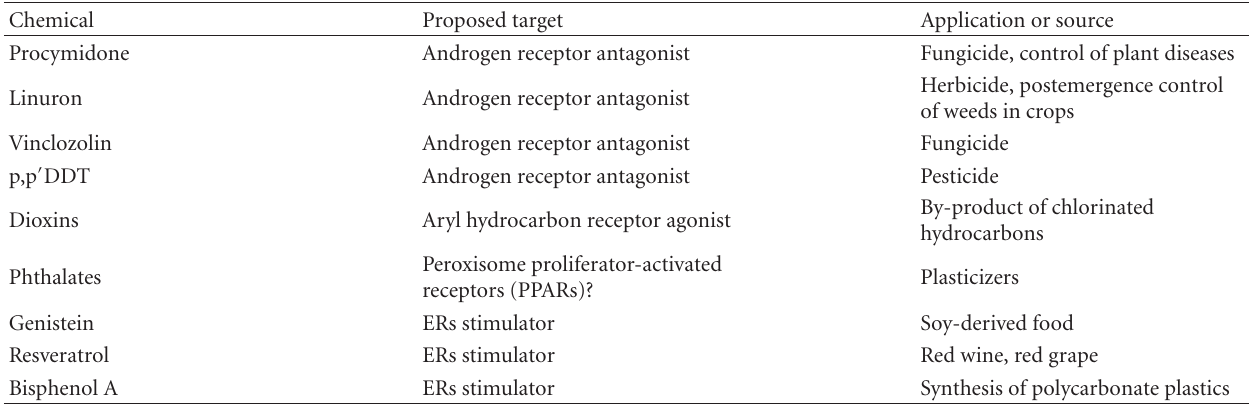
Table 1: Natural and synthetic chemicals a ff ecting Leydig cell